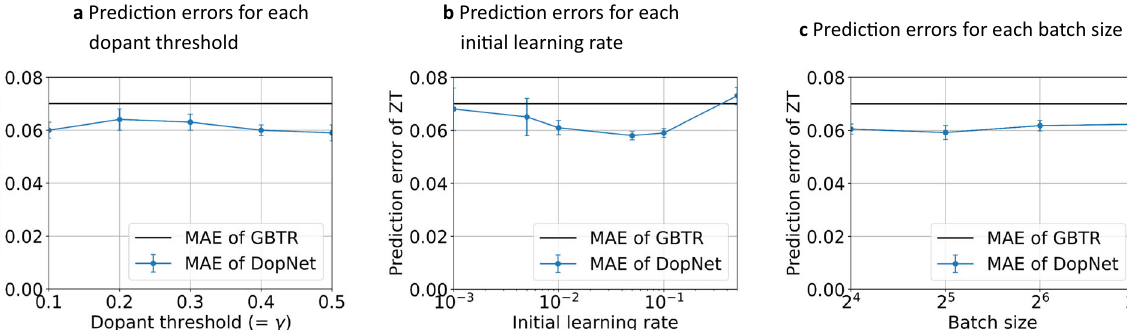
Fig. 5 Prediction errors of DopNet for different values of the hyperparameters. a Prediction errors for different dopant thresholds. b Prediction errors for different initial learning rates of the gradient method. c Prediction errors for different batch